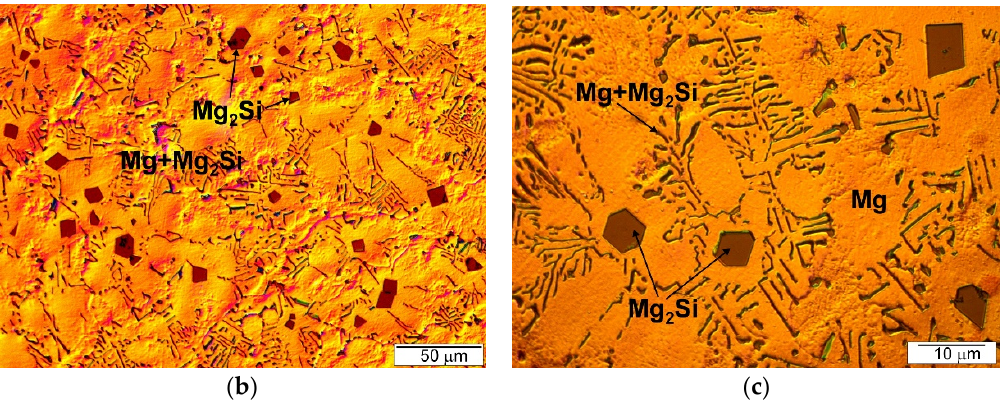
Figure 4. Microstructure of Mg/Mg 2 Si–HR composite ( a – c ) shows three micrographs taken at different magnifications for Mg/Mg 2 Si–HR.